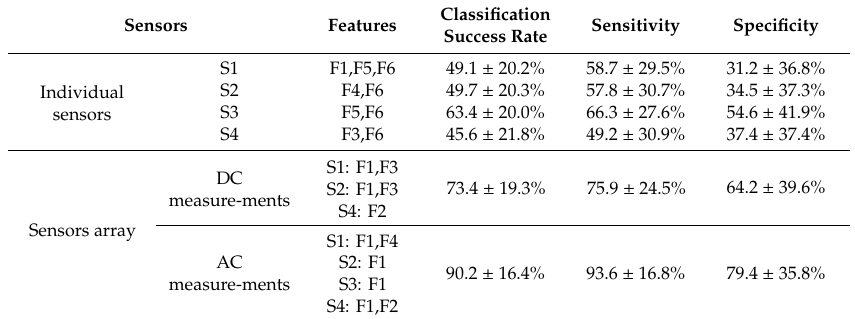
Table 2. Discrimination between the AE patients and controls (mean values (%) ± standard deviation) Sensors Features